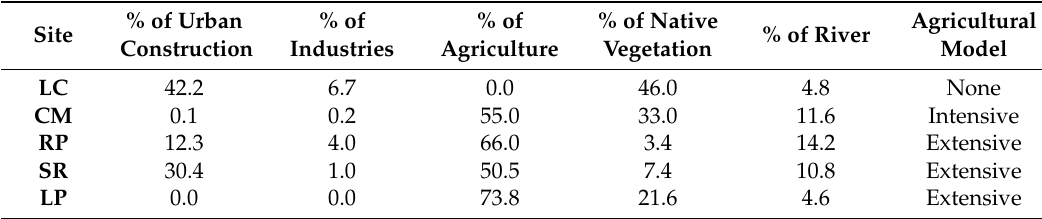
Figure 1. Study sites in the Suquía River basin (Córdoba–Argentina). Table 1. Land uses (percentage) in a 5-km radius of sampling sites in the Suquía River basin, 2010.